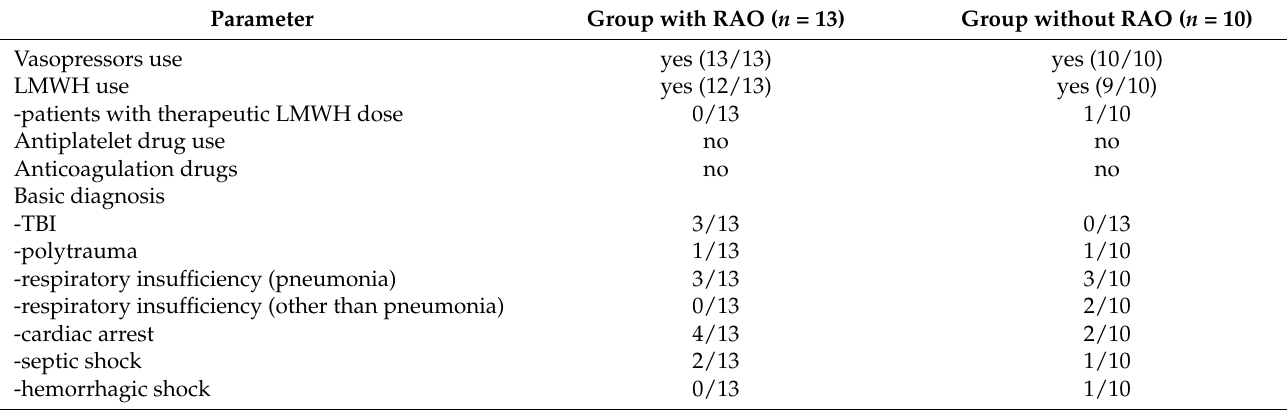
Table 2. Patient’s groups medical